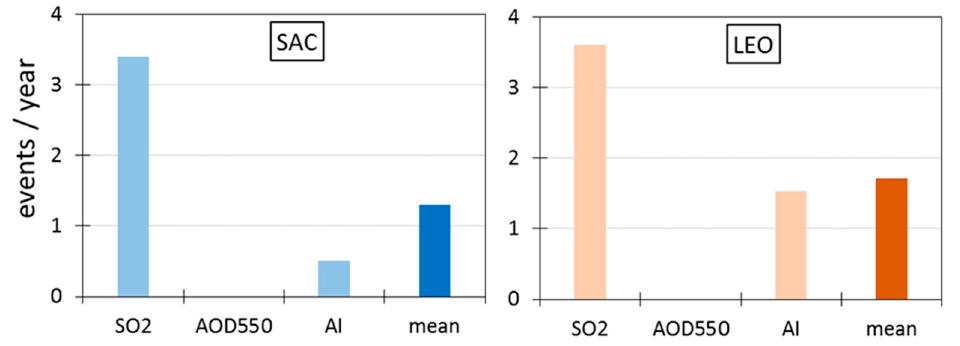
Figure 8. Comparison between the frequency of events from different sources of data (SO 2 total column, AOD550 or AI), and mean value, for the SAC and LEO